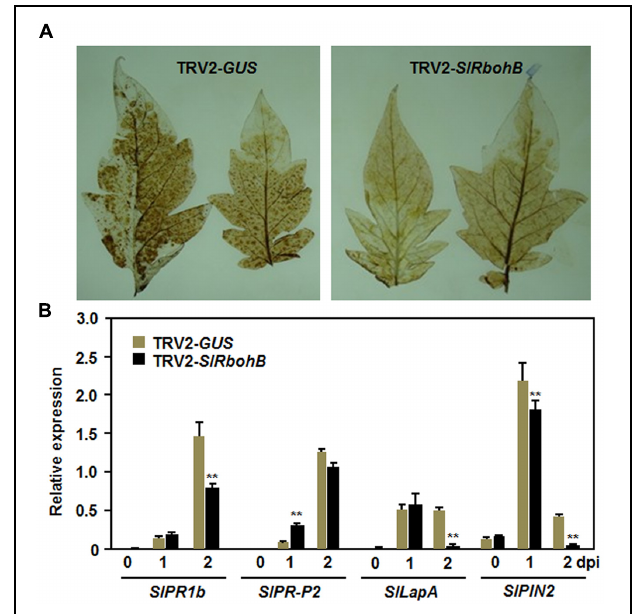
FIGURE 5 | Transient expression of SlRbohB in Nicotiana benthamiana conferred an increased resistance to B. cinerea . Agrobacteria harboring pFGC- SlRbohB or pFGC-eGFP were infiltrated into leaves of 4-week-old N. benthamiana plants and leaf samples were collected for different assays. (A) Expression of SlRbohB in pFGC- SlRbohB- infiltrated leaves. (B) The SlRbohB -GFP fusion protein in pFGC- SlRbohB -infiltrated leaves. Leaf samples were harvested 48 h after infiltration, total soluble proteins were separated by SDS–PAGE, and analyzed by immunoblotting using a GFP-specific antibody. Equal loading of total proteins was verified by Coomassie blue staining. (C) Disease symptom on representative leaves. (D) Lesion sizes. The pFGC- SlRbohB - and pFGC-eGFP-infiltrated leaves were detached at 48 h after infiltration and inoculated by dropping spore suspension (2 × 10 5 spores/mL). Photos were taken and lesion sizes were measured on a minimum of 10 leaves at 5 days after inoculation. Data presented in (A,D) are the mean ± SD from three independent experiments and ∗∗ above the columns indicate significant difference at p < 0.05 level.